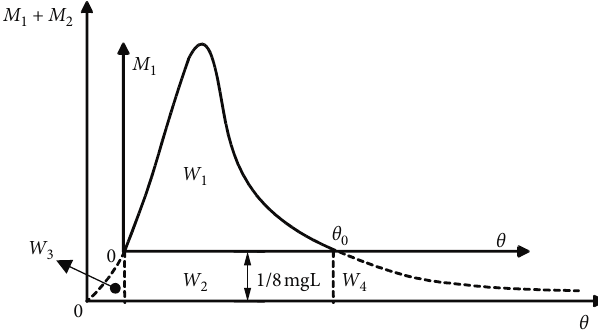
Figure 6: Dynamic fracture model of the beam under TPB test.